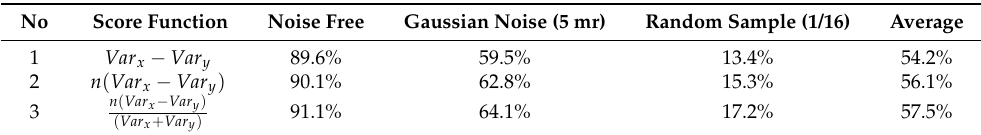
Table 1. The result of different score functions on the SliceLRF.